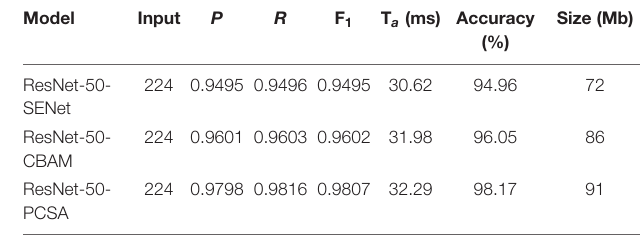
TABLE 3 | The evaluation results.